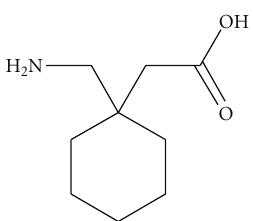
Scheme 1: Structure of gabapentin.